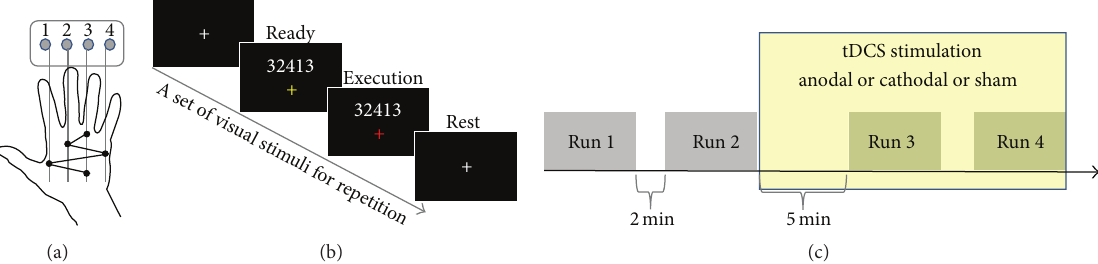
Figure 1: (a) A sequential finger-tapping task was performed utilizing the dominant right hand fingers. (b) Participants were required to repeatedly press a five-element sequence (sequence “32413”) as quickly and accurately as possible during a 10 s trial period. The fixation color turned yellow from white and the numeric sequence (“32413”) appeared for 3 s, indicating the ready period. A red fixation color indicated the 10s execution period. (c) Experimental procedure of the tDCS experiment. During the 1st and 2nd runs, the participants did not receive any stimulation. The third run was begun 5 min after the start of tDCS. The participants performed the 3rd and 4th runs when receiving tDCS (anodal, cathodal, or sham) to the right dorsolateral prefrontal cortex (DLPFC).